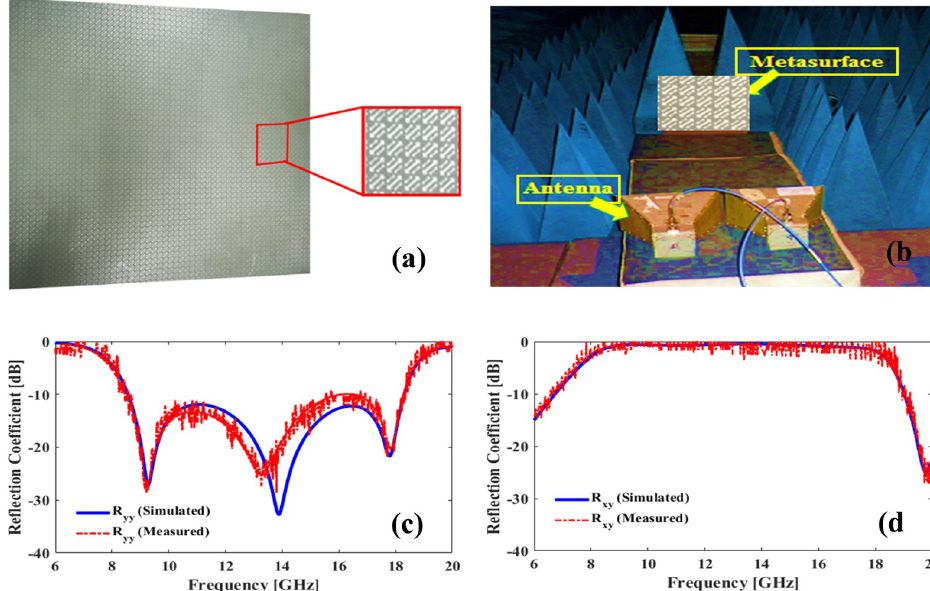
Fig 6. (a) Picture of the fabricated sample. (b) Measurement setup inside an anechoic chamber. (c) simulation and measurement results of co-polarization reflection coefficient R polarization reflection coefficient R xy